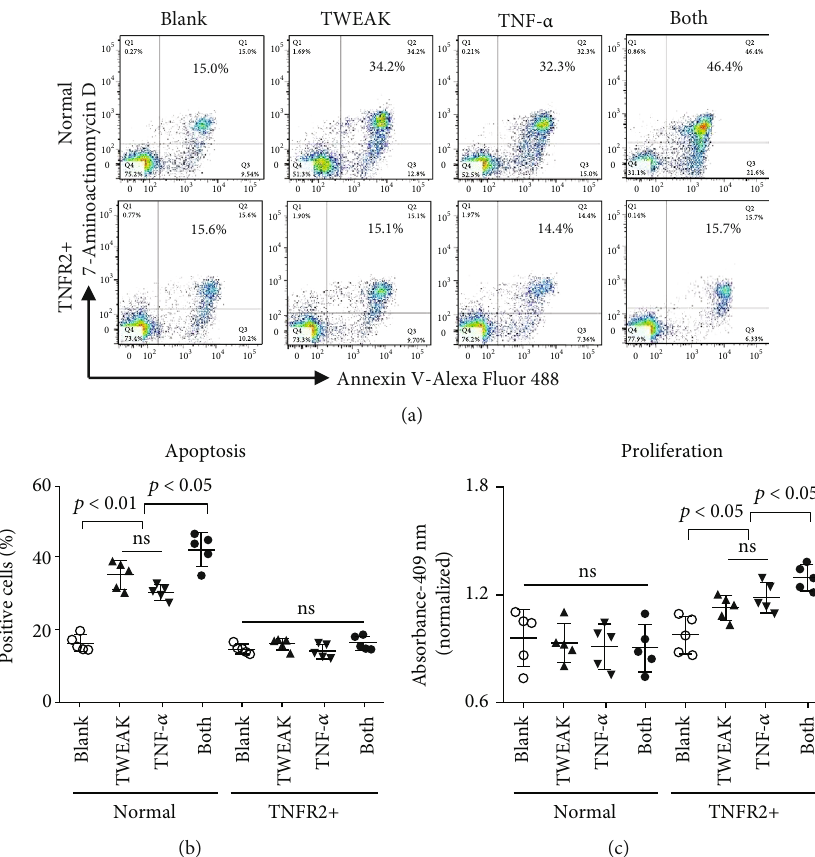
Figure 3: The e ff ect of the TNFR expression pro fi le on TWEAK- or TNF- α -induced cell fate in keratinocytes. Human primary keratinocytes were cultured in vitro and received 48 h stimulation with TWEAK (100ng/ml) or TNF- α (10 ng/ml). TNFR2-overexpressing keratinocytes were constructed using a retroviral vector. (a) Apoptotic cells were quanti fi ed by fl ow cytometry. (b) The ratios of apoptotic cells were compared between di ff erent groups. (c) The proliferation of keratinocytes was quantitated by spectrophotometry, followed by comparison across groups. Data were obtained from fi ve independent experiments. Representative images are shown. ns: not signi fi